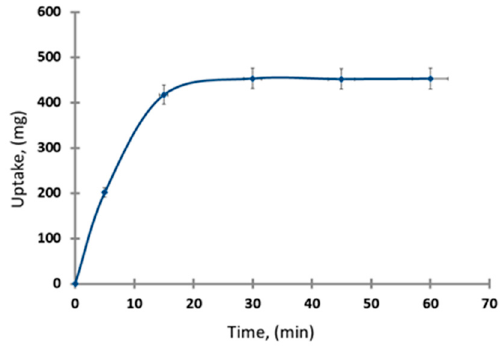
Figure 10. Uptake of Hg(II) based on equilibrium time.